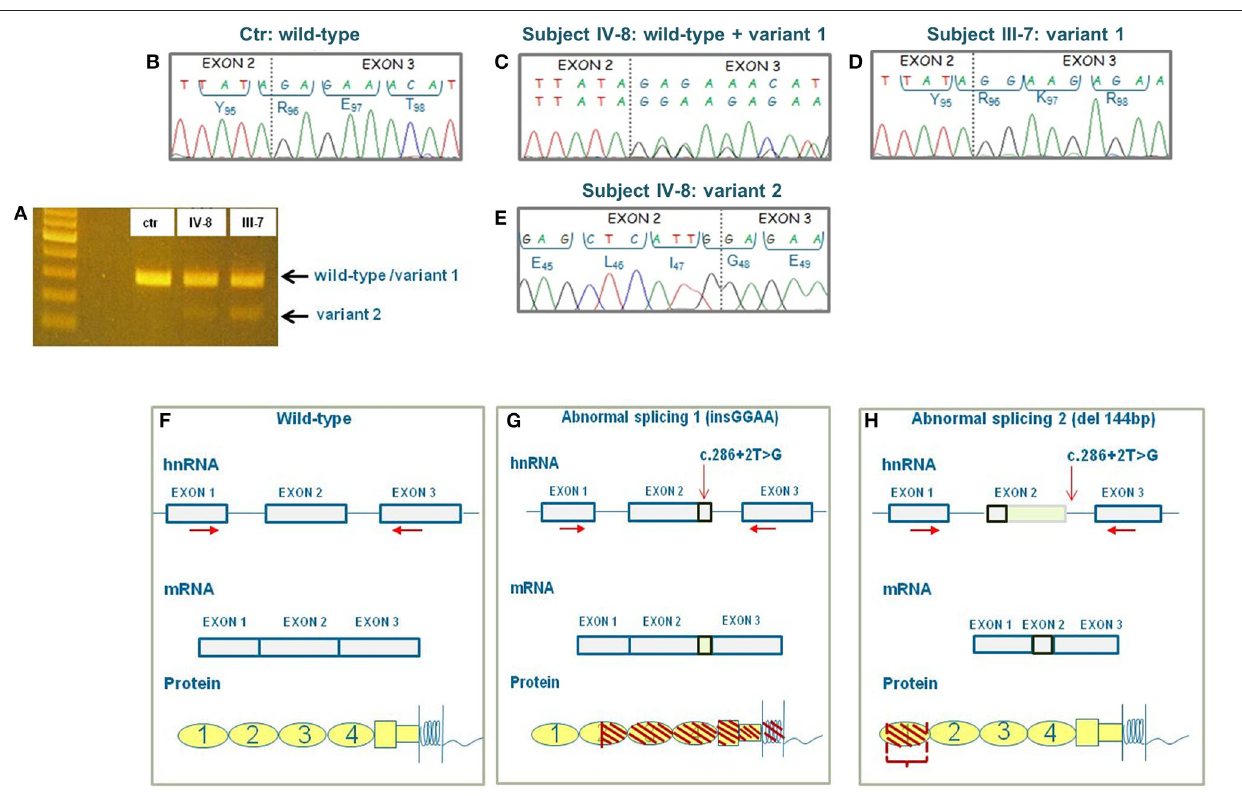
protein, with the addition of several amino acids, followed by a premature truncation at position p.129X